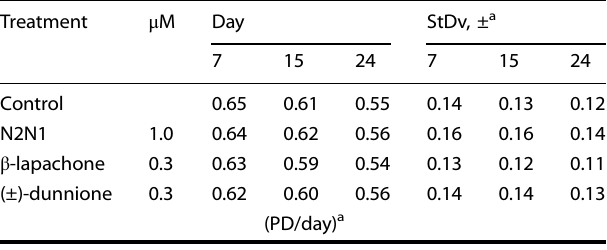
Table 2. RLS in NQO1 knocked out cells cannot be augmented by NQO1-dependent redox mediator treatments